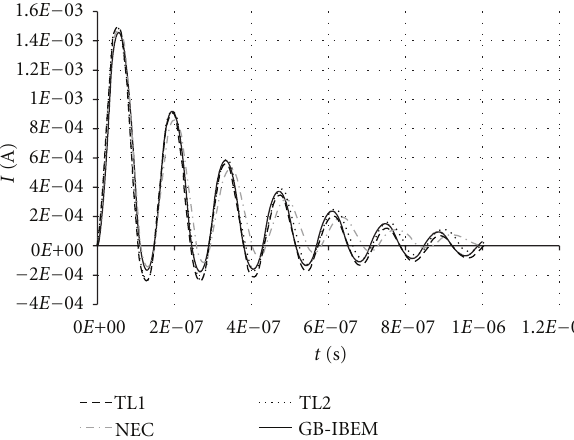
Figure 11: The transient current induced at the center of the line above dielectric half-space ( ε r = 10).